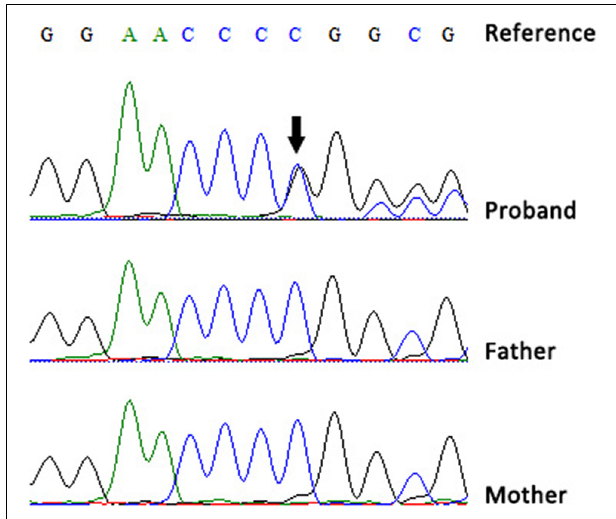
FIGURE 2 | Sequencing chromatograms of the de novo variant in our patient (black